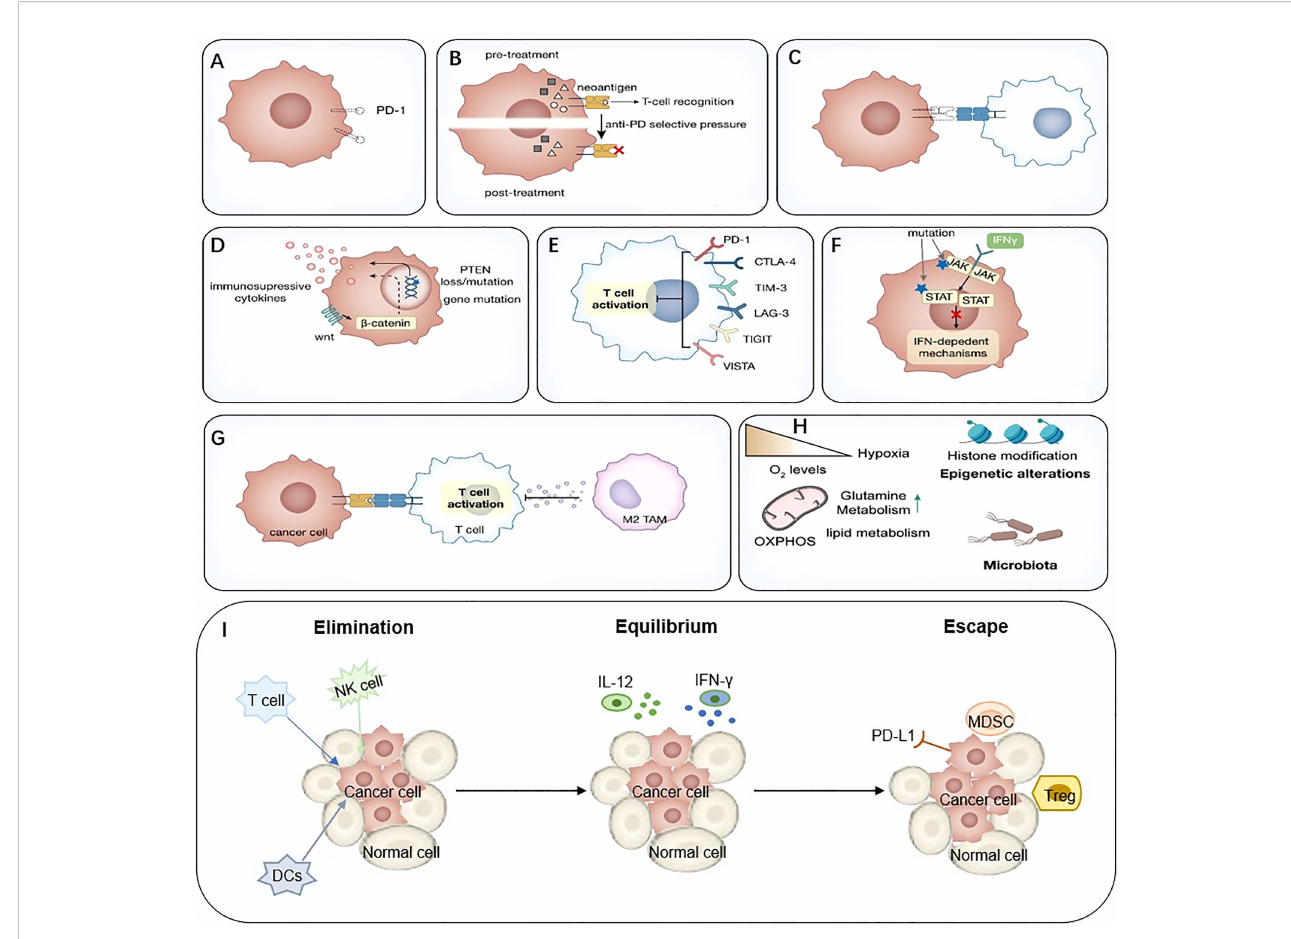
FIGURE 2 Mechanisms of immune-mediated resistance to ICIs. (A) Lack of PD-L1, (B) Neoantigen-depletion, (C) Antigen presentation defect, (D) Tumor-mediated immune-suppression or – exclusion, (E) Immune inhibitory receptors, (F) Abnormal IFN signaling pathway, (G) Immunosuppressive cells, (H) Metabolic reprogramming, (I) The ‘ 3Es ’ hypothesis. IFN, interferon; ICIs, immune checkpoint